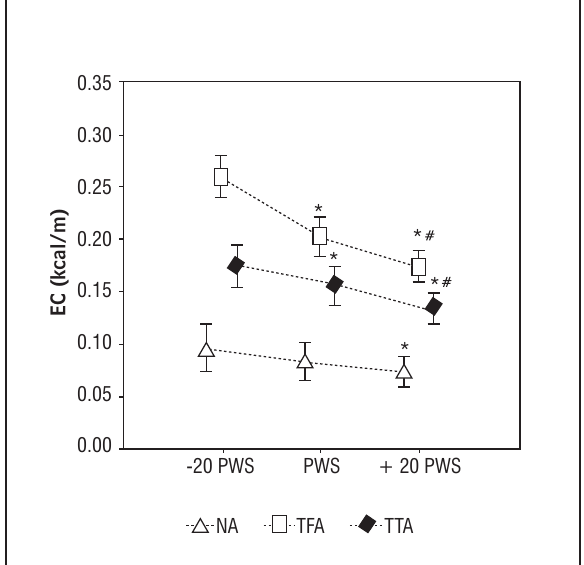
Figure 3 - Intragroup comparison regarding energy cost (EC) with increasing gait speed (-20 PWS; PWS and +20 PWS), reached by the Non Amputee (NA), Transtibial Amputee (TTA) and Transfemoral Amputee (TFA) groups. Data are presented as mean and 95 % confidence